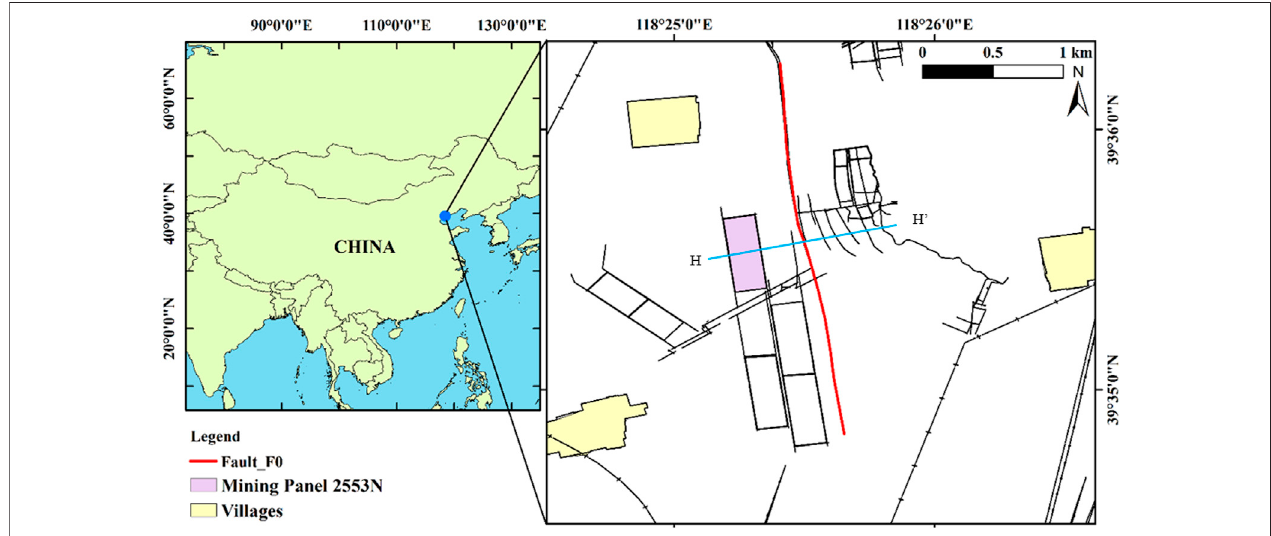
FIGURE 1 | Location of the study area. Blue spot is Fangezhuang coal mine in Tangshan city. Purple rectangle area is mining panel 2553N. Red line shows the F0 geological